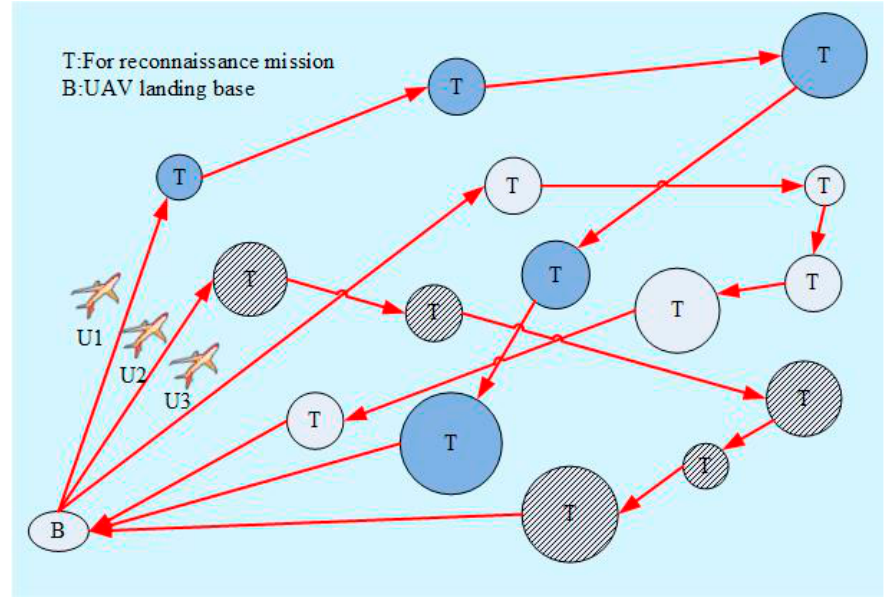
Figure 1. Multi-unmanned aerial vehicle (UAVs) reconnaissance mission planning schematic diagram.